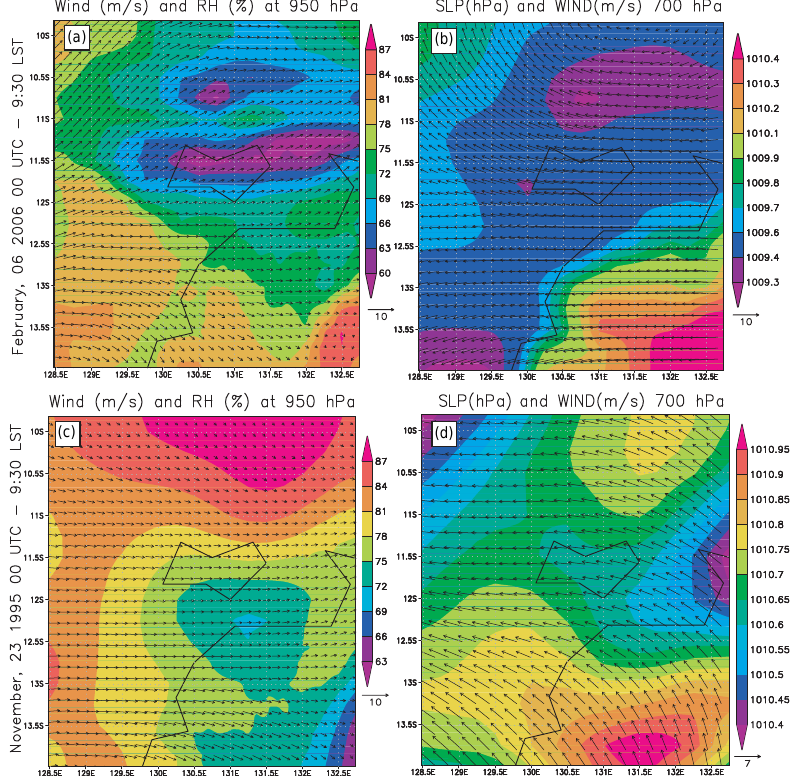
Figure 3. ECMWF analysis over the Tiwi Islands at 00:00UTC for F6 and N23. Panels (a, c) report surface wind and relative humidity at 950hPa; panels (b, d) report sea level pressure in filled contours and wind flow vectors at 700